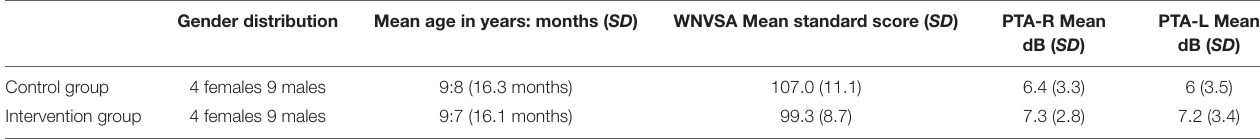
TABLE 1 | Means and SDs of age, performance in the WNVSA, mean PTA score of all frequencies for each ear, and gender distribution for each group. Gender distribution Mean age in years: months ( SD